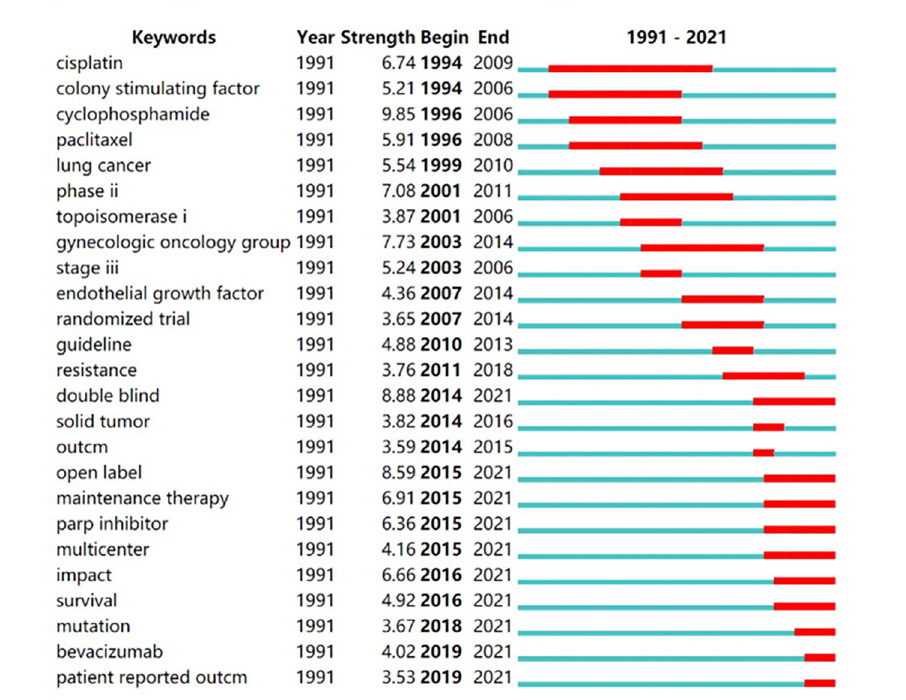
Fig 7. Map of the top 25 keywords with the strongest citation